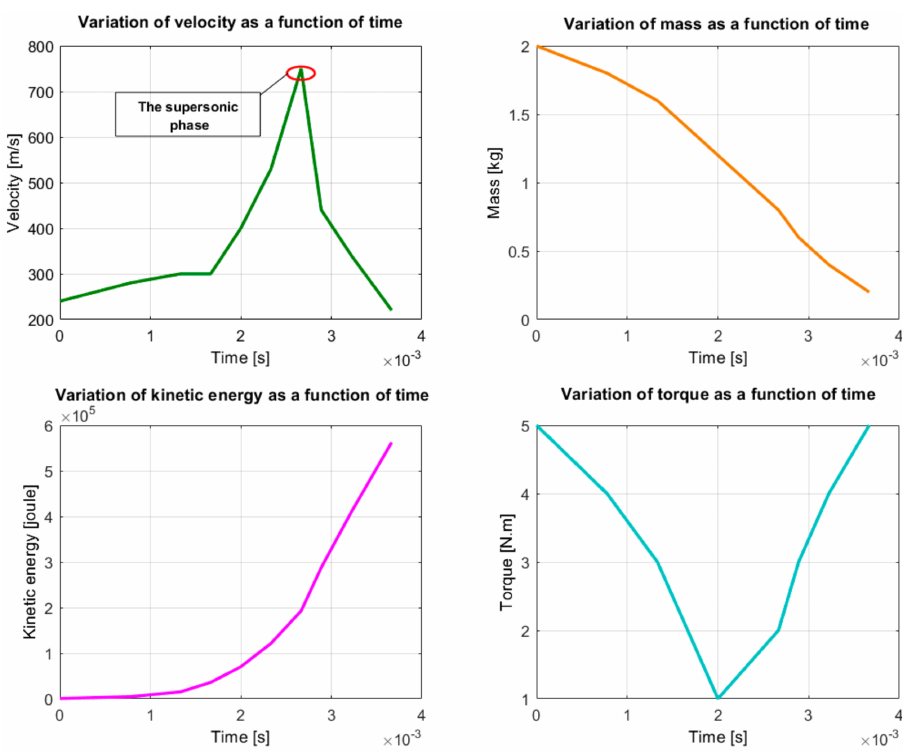
Figure 5. The motion of a whip.